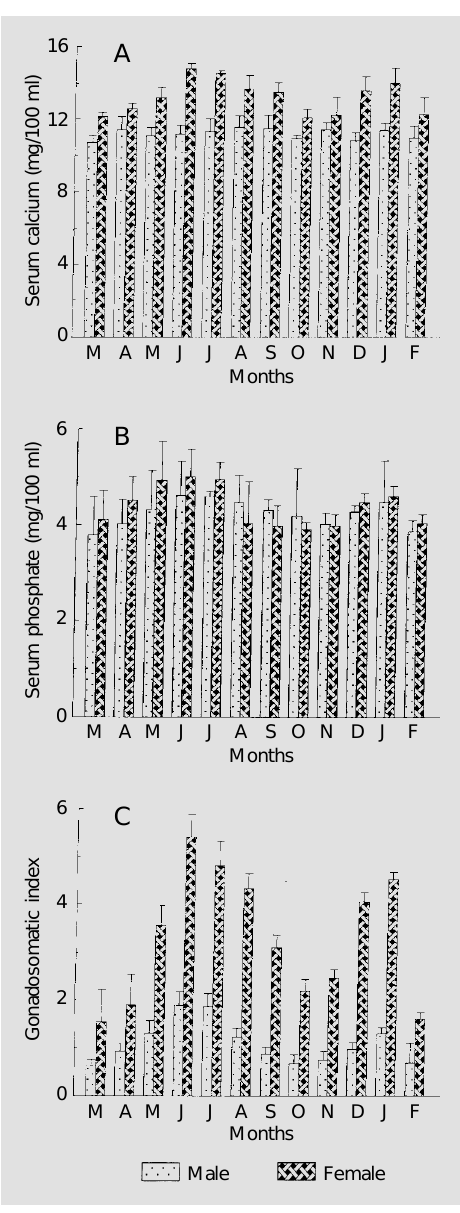
Figure 1 - Seasonal changes in serum calcium (A) and phosphate (B) levels and gonadosomatic index (C) of male and female Channa punctatus . Each value repre- sents the mean ± SD of ten specimens.